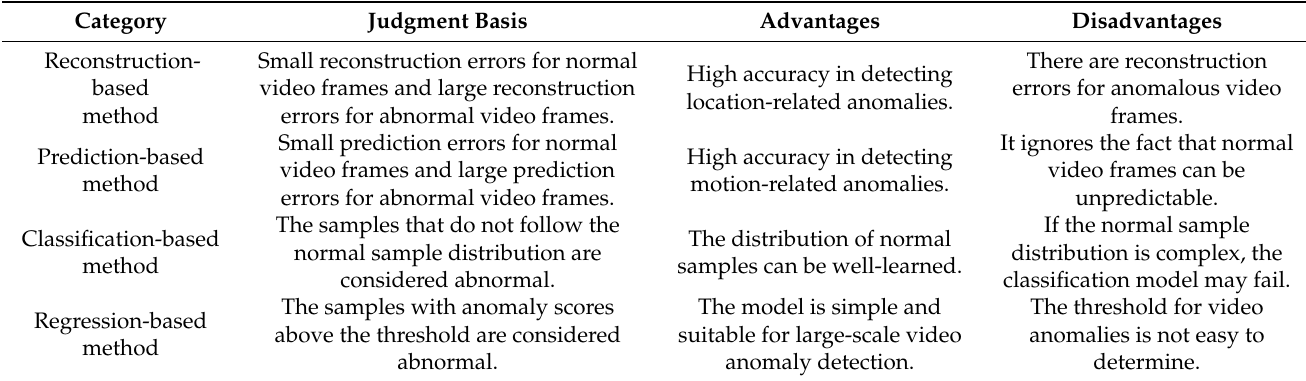
Table 1. Comparison and summary of different kind of